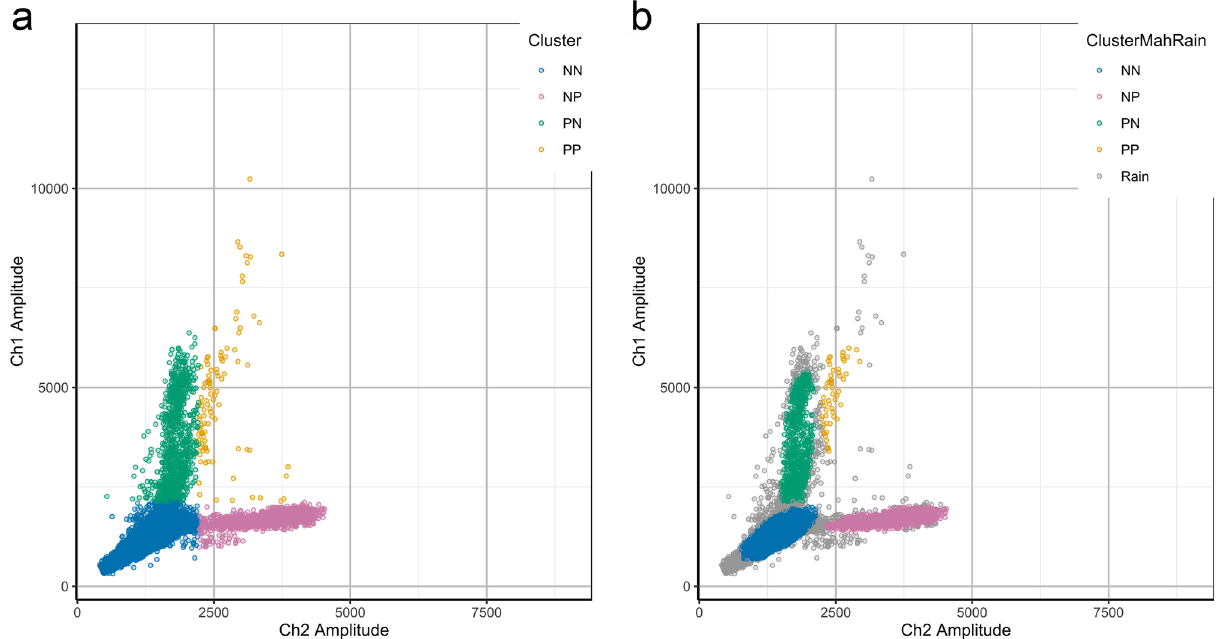
Figure 2. Manual classification of ddPCR overlooking rain droplets or excluding rain droplets. Representative results of the analysis of 21 samples and the negative and the positive controls. All droplets are combined into a single plot. The channel 1 axis represents mutation-specific Taqman probe (VIC fluorescence) and channel 2 axis represents a wild-type Taqman probe (FAM fluorescence). ( a ) Plot with classification of the droplets without exclusion of “rain droplets”. It is possible to observe that all droplets are classified in four groups. ( b ) Plot with classification of the droplets after exclusion of “rain droplets”. It is possible to observe that extreme droplets were removed, including broken droplets, which have very low fluorescence in both axes. Droplets that were hard to classify, as they are very close to one or more clusters, were also removed. NN = No DNA; NP = positive for wild type BRAF; PN = positive for BRAF V600E; PP = positive for both wild type and mutated BRAF; Rain = droplets hard to classify, excluded from the analysis.